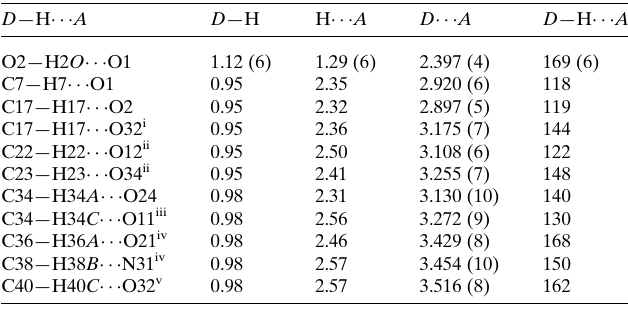
Table 4 Hydrogen-bond geometry (A˚ , (cid:2) ) for I